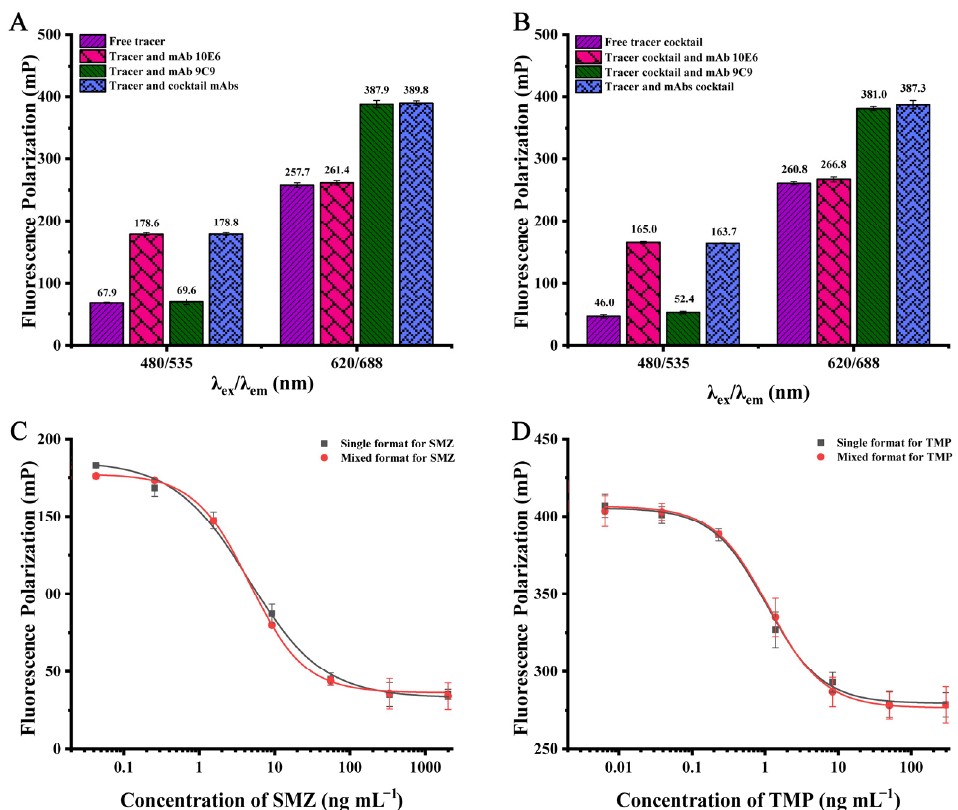
Figure 3. Binding of the single tracer ( A ) and the tracer cocktails ( B ) with mAbs at the working concentration. Standard curves for SMZ, TMP, and the standard cocktail in mixed format at different wavelengths: ( C ) λ ex 480 nm/ λ em 535 nm ( n = 3); ( D ) λ ex 620 nm/ λ em 688 nm ( n = 3).